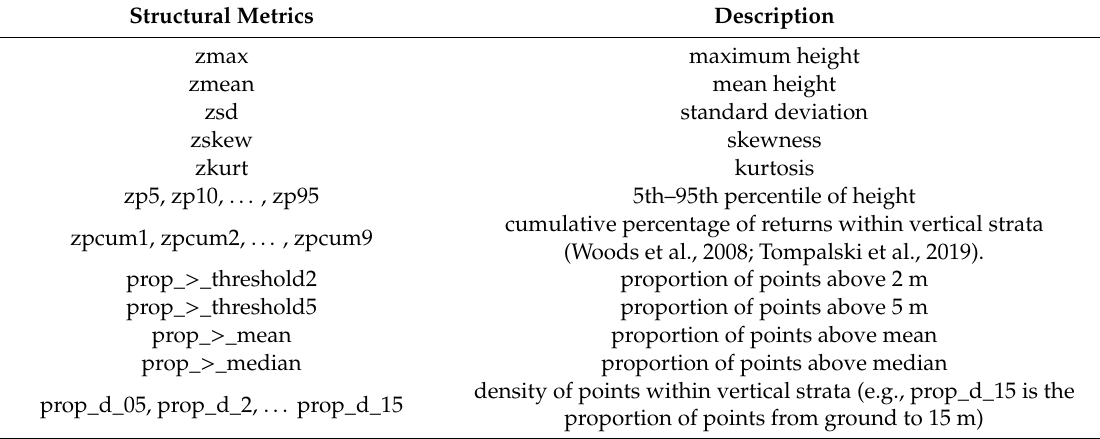
Table 3. List of structural metrics calculated for M-ALS point clouds.